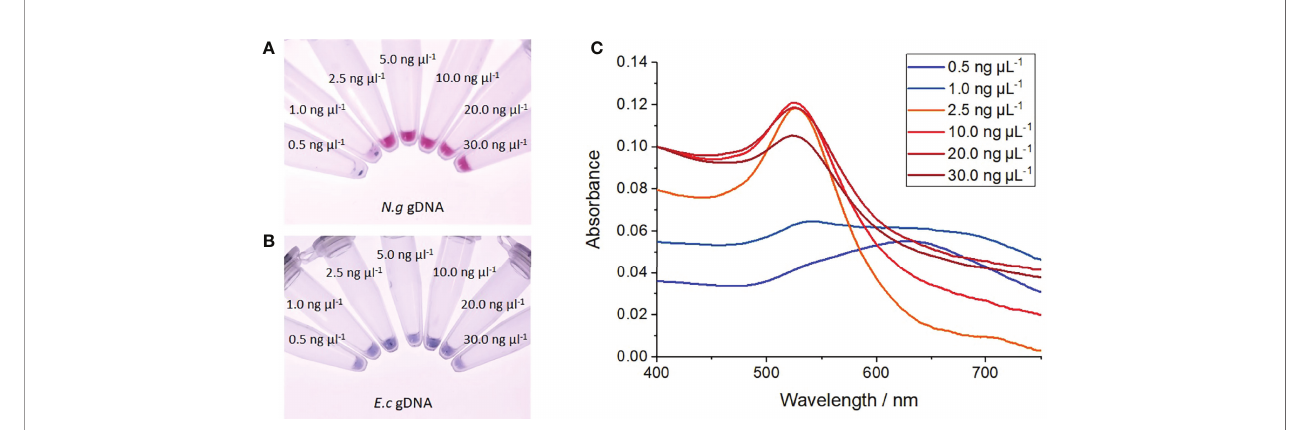
FIGURE 4 | Salt-induced aggregation tests with genomic DNA. (A) Photograph of nanoprobes after incubation with increasing concentrations of N. gonorrhoeae (MS11) genomic DNA, heating to 95°C, before cooling to room temperature and treated with 40 mM MgSO 4 , (B) Photograph of nanoprobes after treatment as before but with E coli (Stellar) genomic DNA, (C) UV-vis absorption spectra of gold nanoprobe samples following treatment with increasing concentrations of N. gonorrhoeae DNA. Each experiment was repeated 3 times, with photographs shown from 1